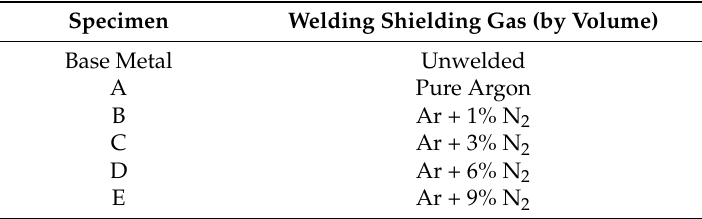
Table 2. Specimens and welding shielding gasses.